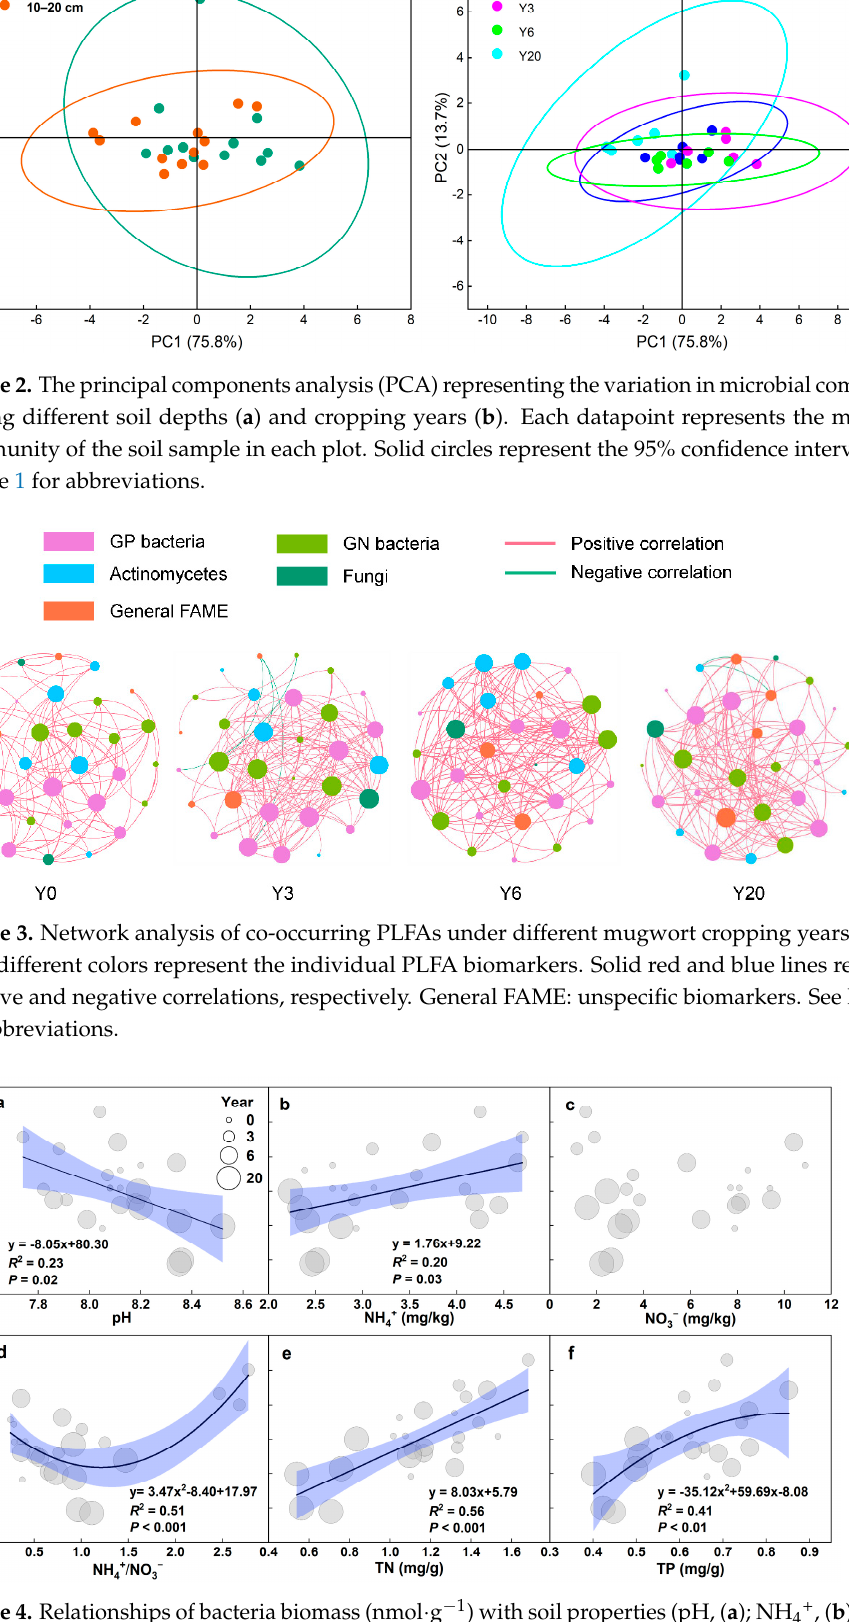
Figure 5. Relationships of actinomycetes biomass (ACT biomass, nmol·g − 1 ) with soil properties (pH, ( a ); NH 4+ , ( b ); NO 3 − , ( c ); NH 4+ /NO 3 − , ( d ); TN, ( e ); TP, ( f )). See abbreviations in Table 2.